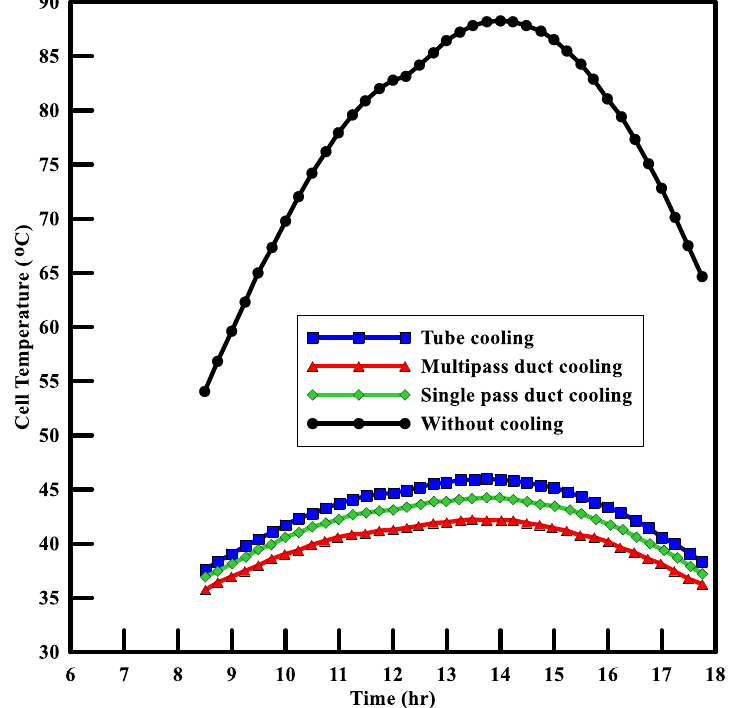
Figure 6. Cell temperature over the whole day for 9th of June.